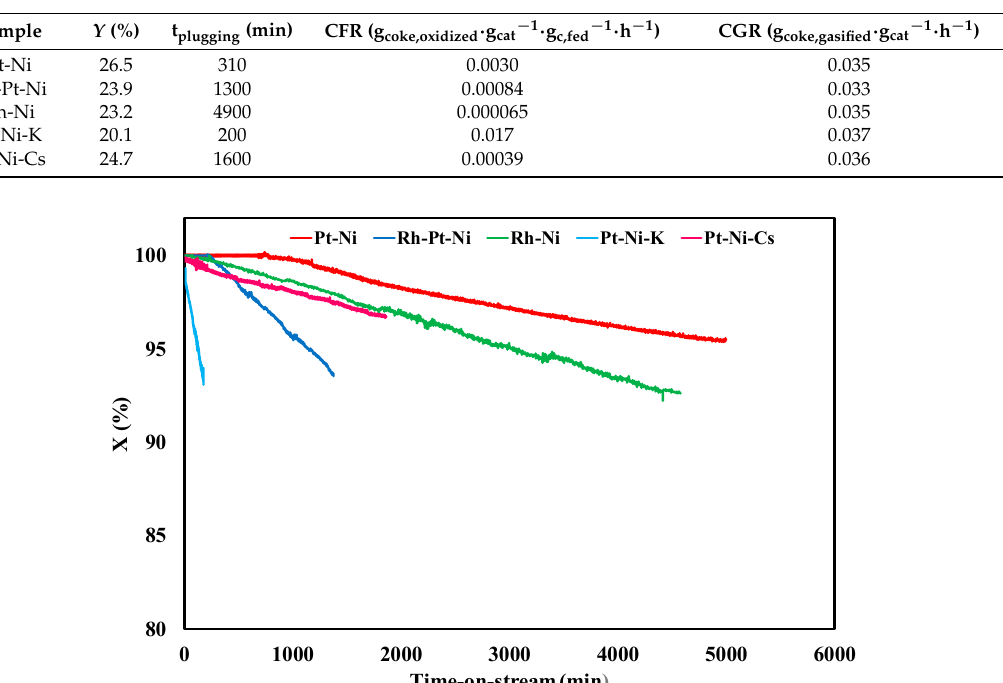
Table 3. Initial hydrogen yield ( Y ), plugging time corresponding to 500 mbar (t plugging ), carbon formation rate (CFR), and carbon gasification rate (CGR) during stability tests carried out at 450 °C, f.r. = 3, and WHSV = 4.1 h − 1 .